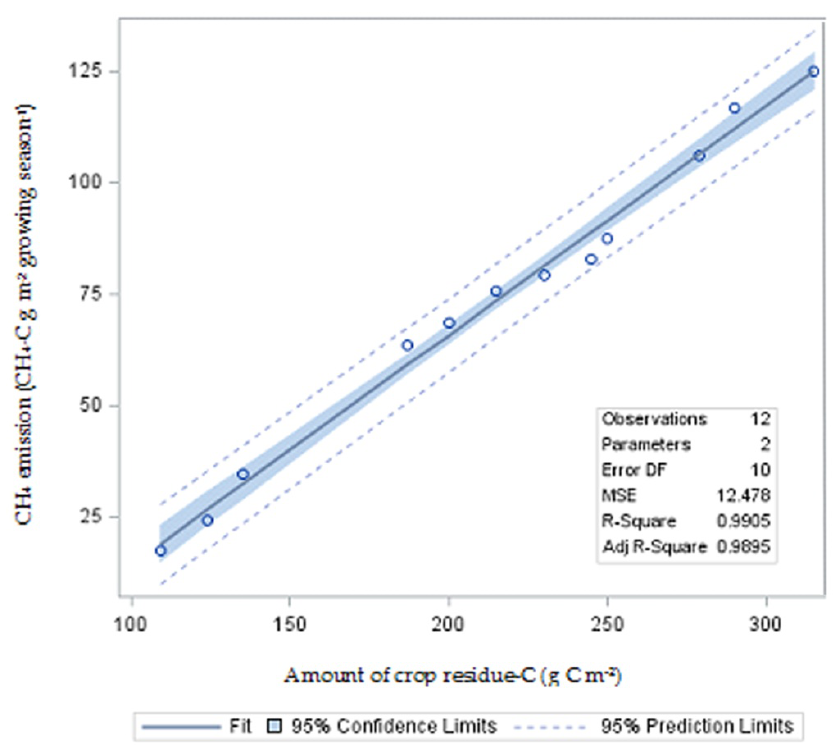
Figure 5. Relationship between the amount of organic residue C and total CH 4 emissions measured during rice growing season.